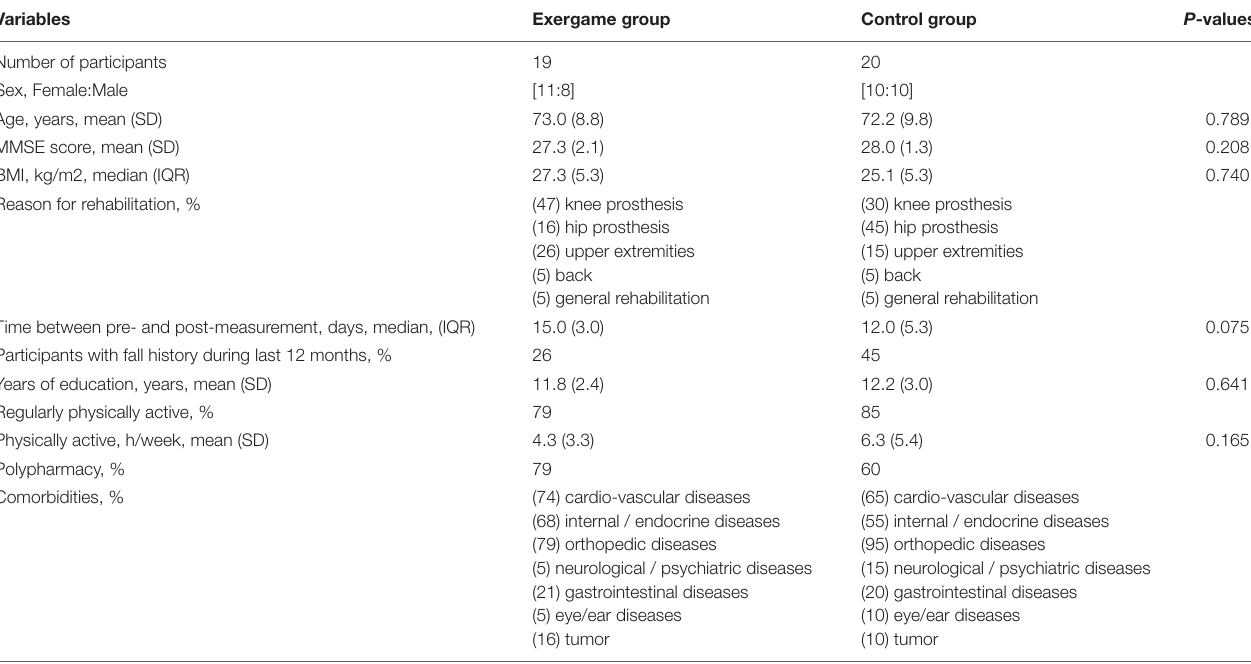
TABLE 1 | Demographics of study